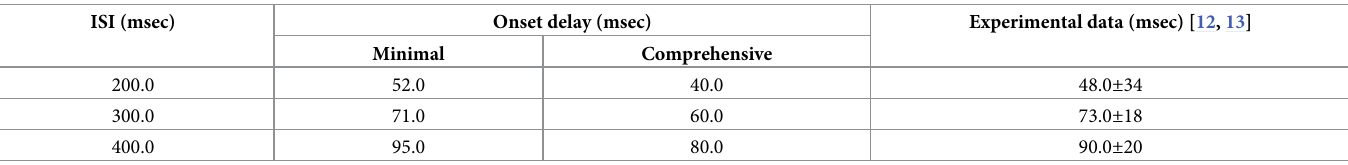
Table 3. Onset delay for different conditional responses of the Purkinje